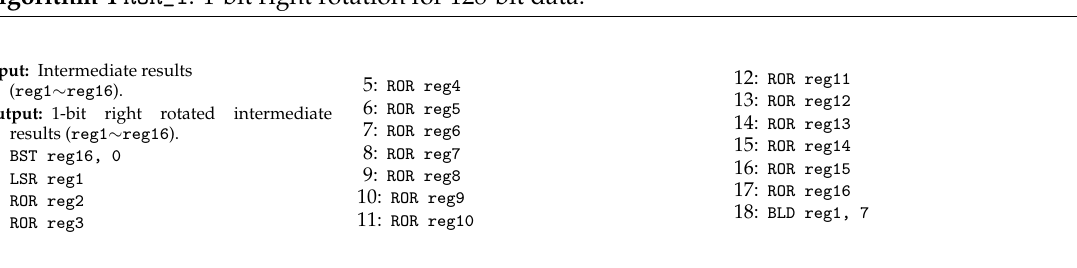
Algorithm 4 ROR_1 : 1-bit right rotation for 128-bit data.